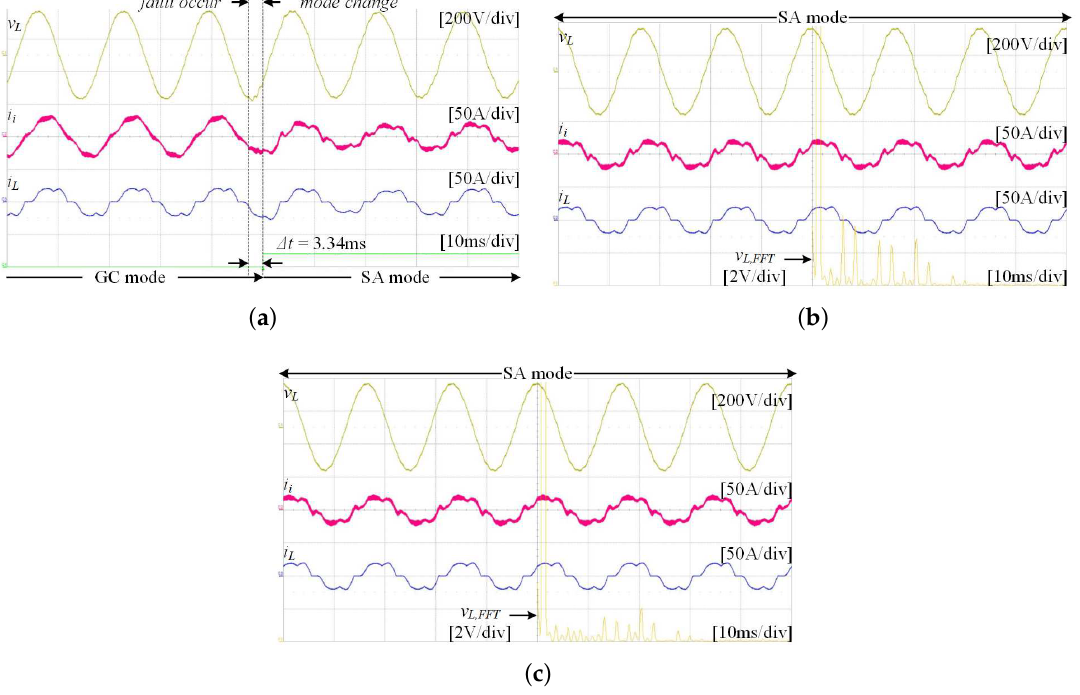
Figure 15. Experimental results ( a ) from grid-connected to stand-alone mode operation with 3 kW non-linear load; ( b ) stand-alone mode operation without harmonic compensation ( c ) stand-alone mode operation with harmonic